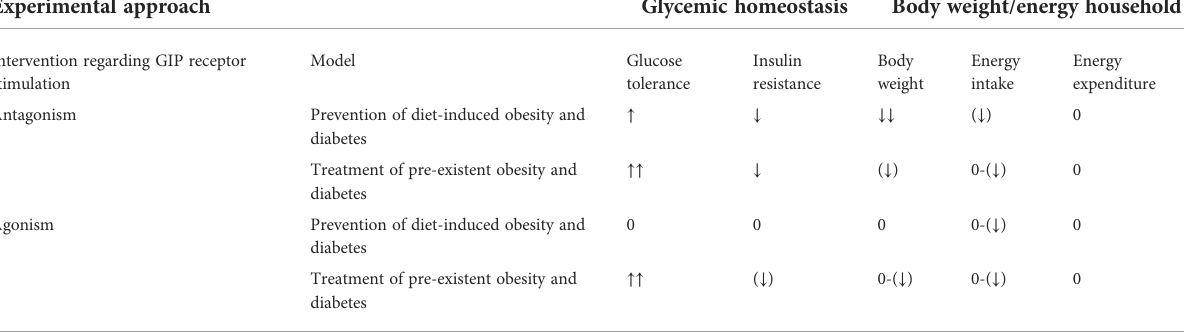
TABLE 1 Effects of GIP receptor agonism or antagonism on glycemic control, body weight, and energy balance in animal models of obesity and diabetes (modi fi ed according to Campbell and Nauck) ( 47 , 49 ). Experimental